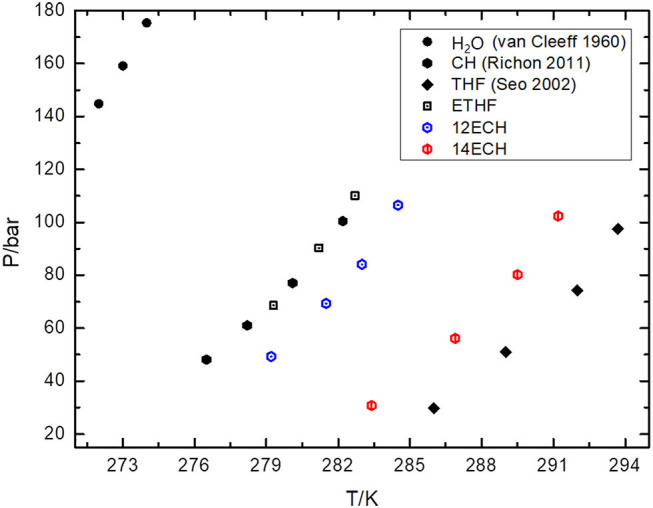
Equilibrium P-T conditions of N2 hydrates containing various promoters (xLGM = 0.0556).